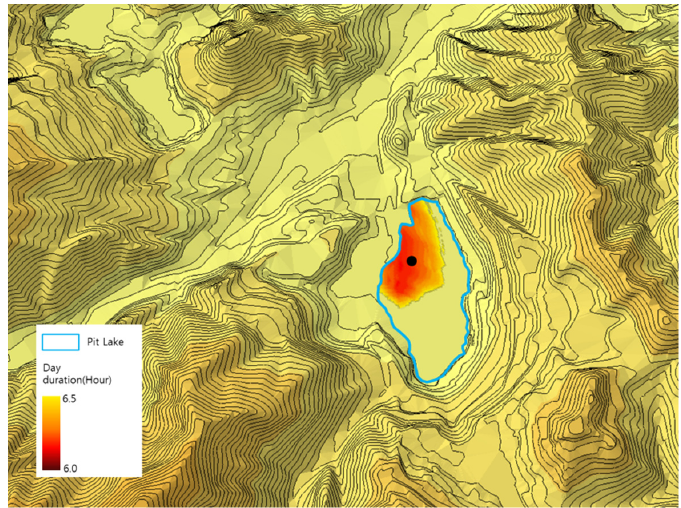
Figure 3. Daylight duration of 6.0–6.5 hour/day in the study area. The black spot represents the location from which the skyline was recorded by SunEye210.